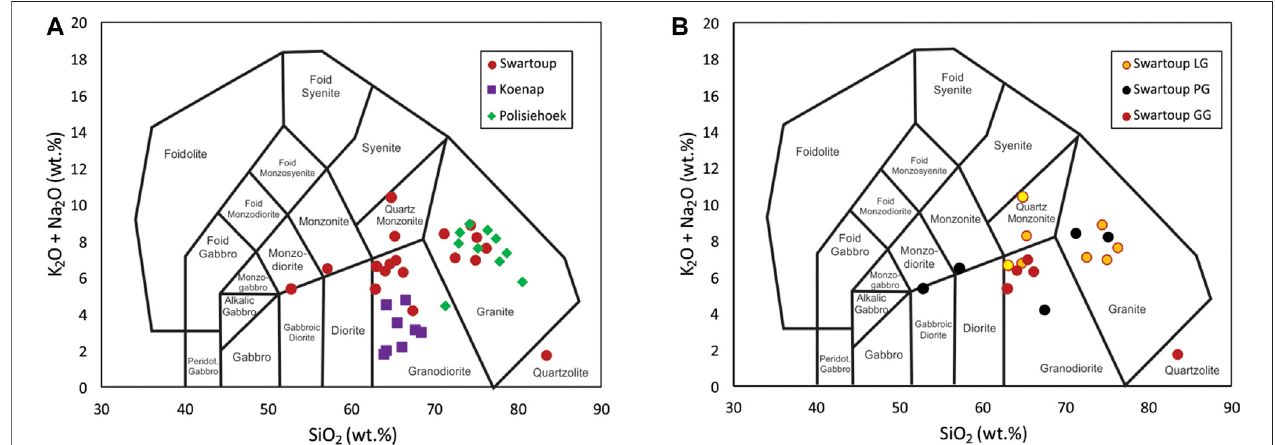
FIGURE 4 | (A) Total alkali vs. silica (TAS) diagram (after Middlemost, 1994) for classi fi cation of Swartoup Pluton granitoids and the Polisiehoek granite gneisses. Koenap Formation migmatites are plotted for compositional reference (as opposed to classi fi cation) purposes only. In (B) , the Swartoup granitoids are subdivided according to their modal compositions into leucogranitoids (LG) with biotite as the sole ma fi c phase, pyroxene-bearing granitoids (PG), and garnet-bearing granitoids (GG). See text for